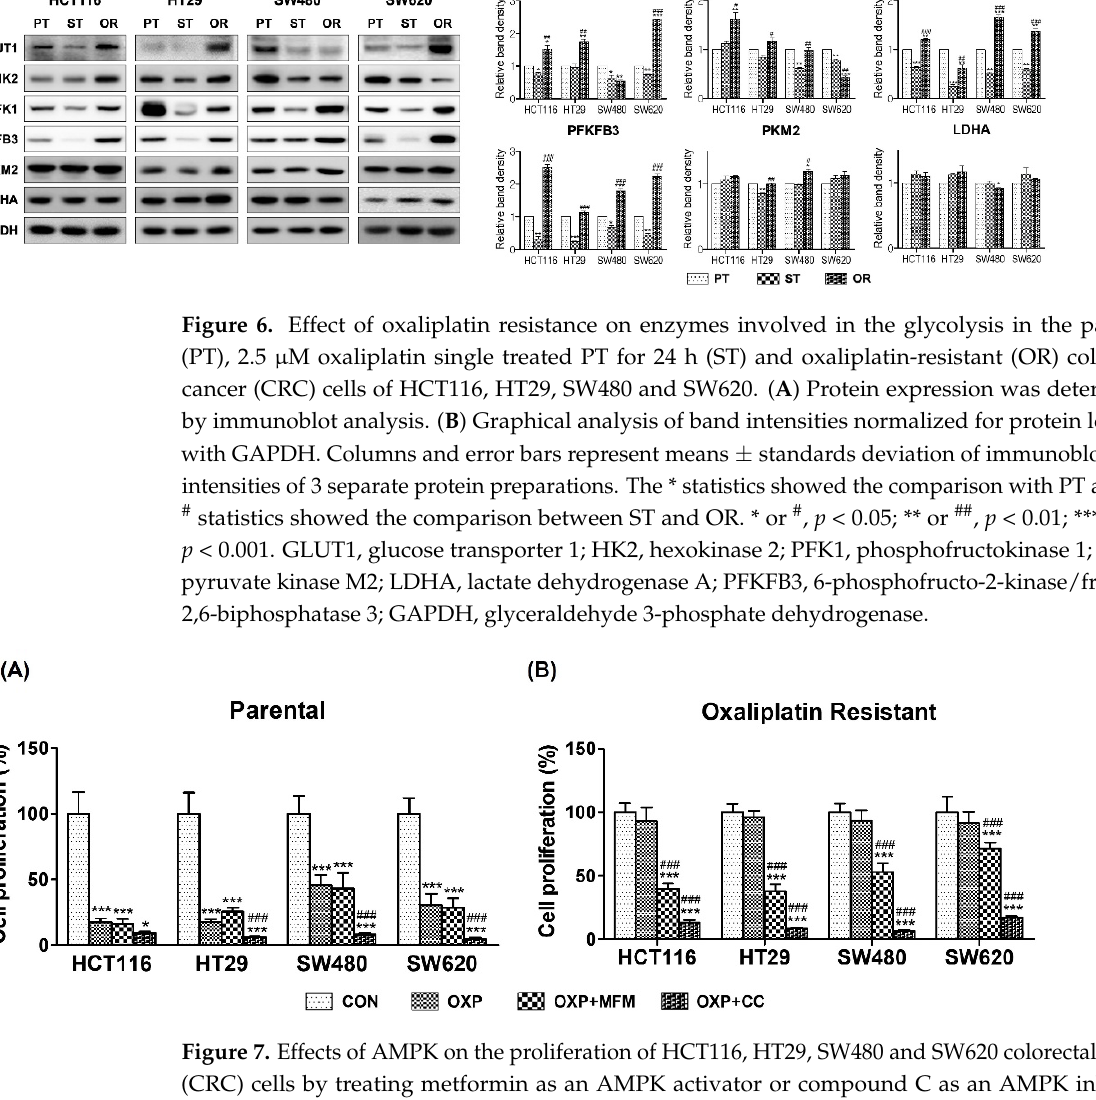
Figure 6. Effect of oxaliplatin resistance on enzymes involved in the glycolysis in the parental (PT), 2.5 µM oxaliplatin single treated PT for 24 h (ST) and oxaliplatin-resistant (OR) colorectal cancer (CRC) cells of HCT116, HT29, SW480 and SW620. ( A ) Protein expression was determined by im- munoblot analysis. ( B ) Graphical analysis of band intensities normalized for protein loading with GAPDH. Columns and error bars represent means ± standards deviation of immunoblot band in- tensities of 3 separate protein preparations. The * statistics showed the comparison with PT and the # statistics showed the comparison between ST and OR. * or # , p < 0.05; ** or ## , p < 0.01; *** or ### , p < 0.001. GLUT1, glucose transporter 1; HK2, hexokinase 2; PFK1, phosphofructokinase 1; PKM2, py- ruvate kinase M2; LDHA, lactate dehydrogenase A; PFKFB3, 6-phosphofructo-2-kinase/fructose- 2,6-biphosphatase 3; GAPDH, glyceraldehyde 3-phosphate dehydrogenase.